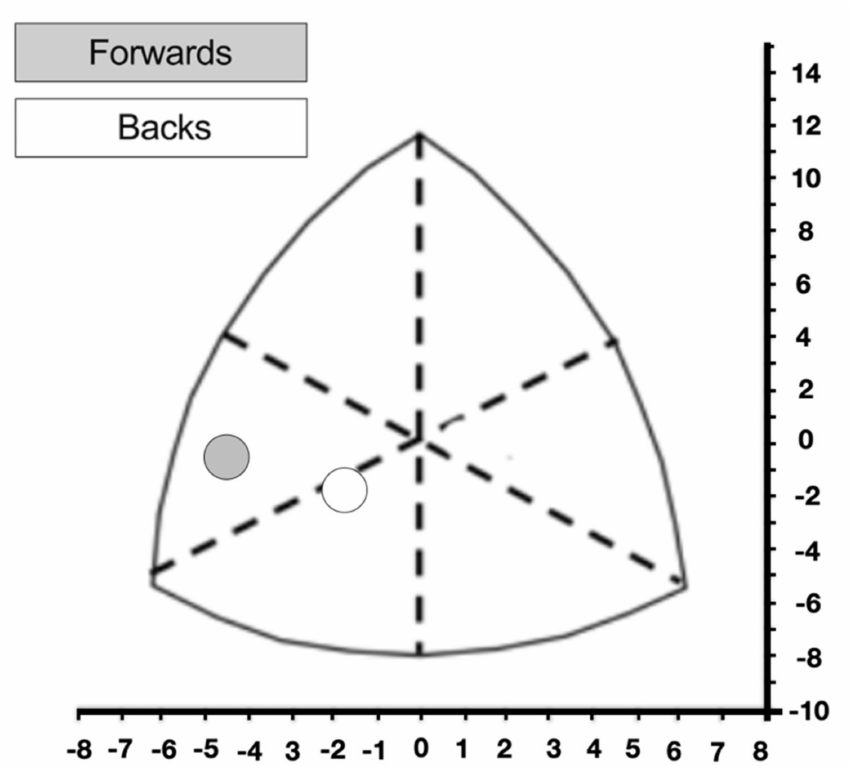
Figure 2. Body composition diagram of the two groups of female rugby players according to Carter and Heath